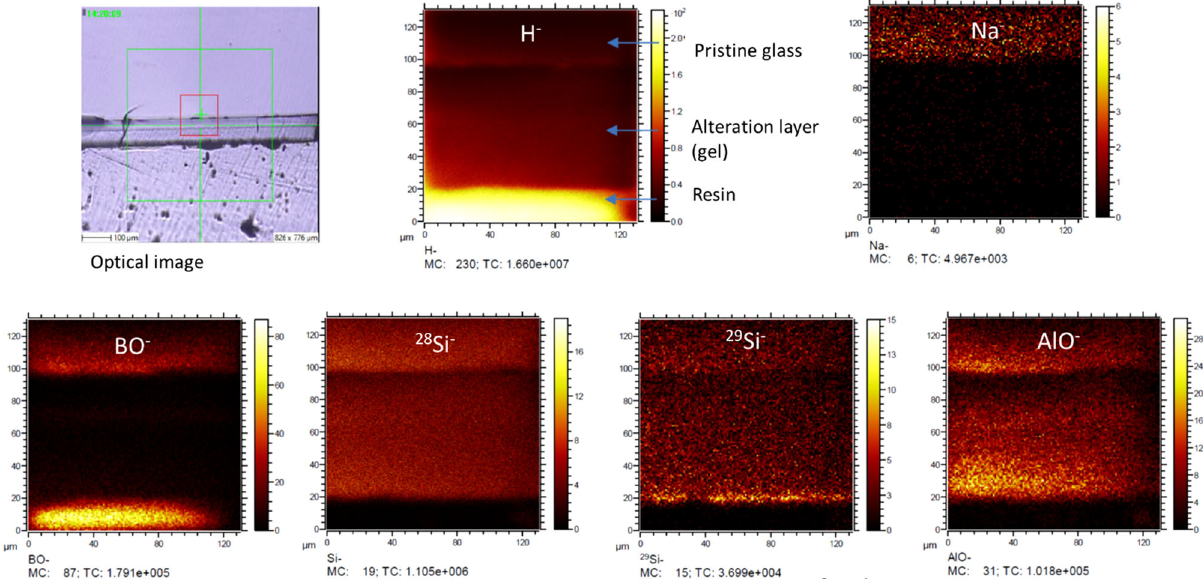
Fig. 9 ToF-SIMS elemental and isotopic mappings of sample F (pre-irradiated glass altered for 83 days at pH 3 in silica saturation conditions). Note that the mappings are recorded within the green square shown on the optical image but do not correspond to the red